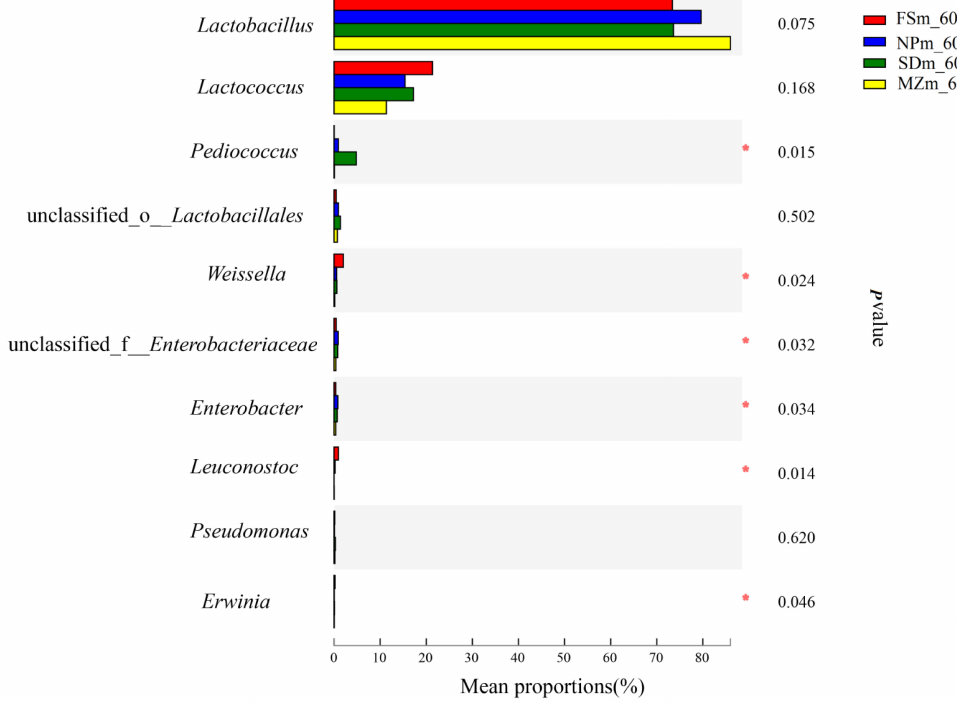
Figure 6. One-way analysis of variance bar plots of the genus level (10 most abundant genera) among different forage sorghum silage groups. *, 0.01 < p < 0.05. FSm, forage sorghum microbiota; NPm, Napier grass microbiota; SDm, Sudan grass microbiota; MZm, maize microbiota; 60, 60 days of